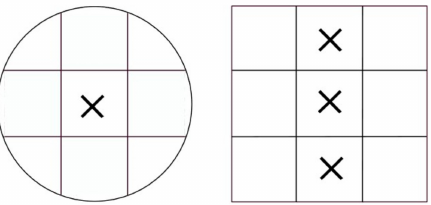
Figure 4. Positions of the samples cut from the cylindrical furan samples for Mercury intrusion porosimetry. ‘x’ corresponds to the porosimetry sample’s center.